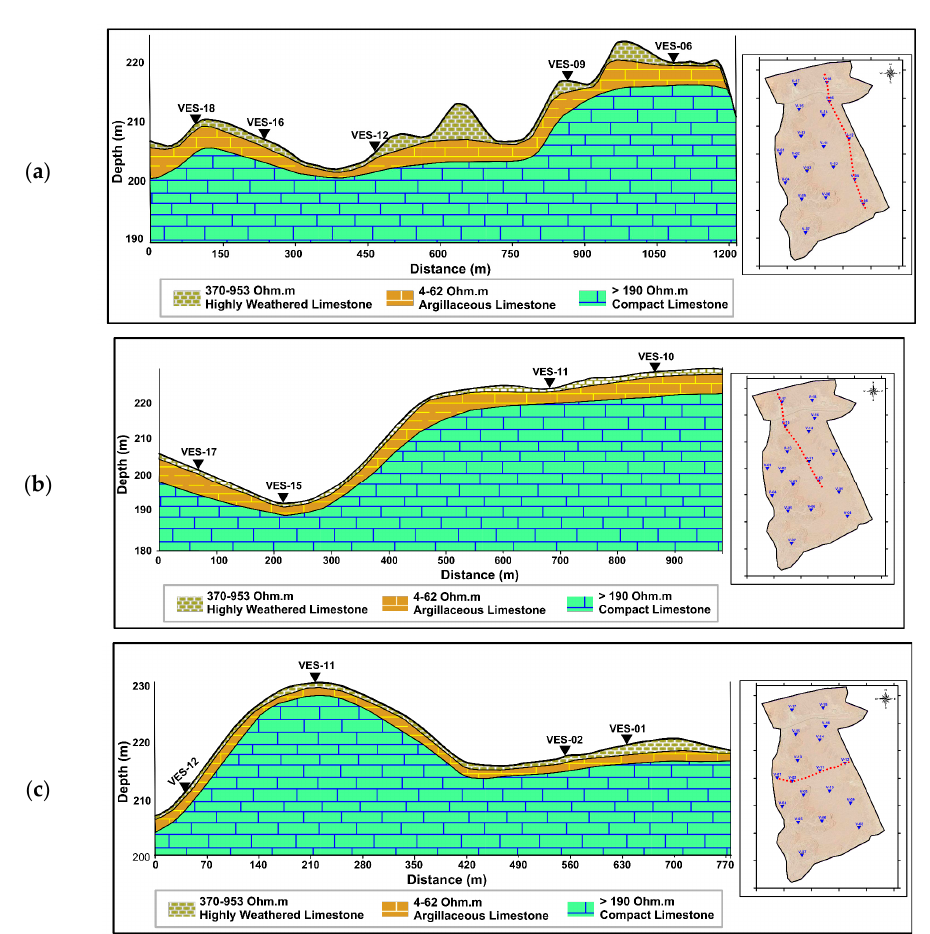
Figure 14. Geoelectric resistivity cross-sections: ( a ) profile-01, ( b ) profile-02, and ( c ) profile-03.